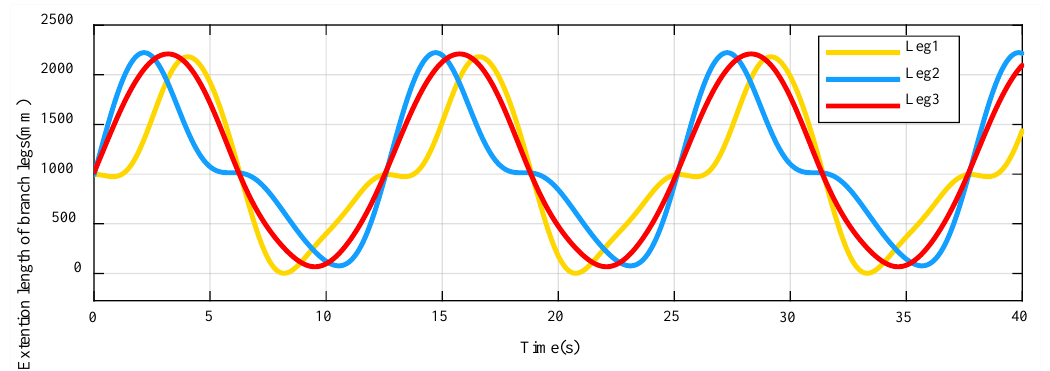
Figure 25. Leg elongation extent of the novel wave compensation platform.